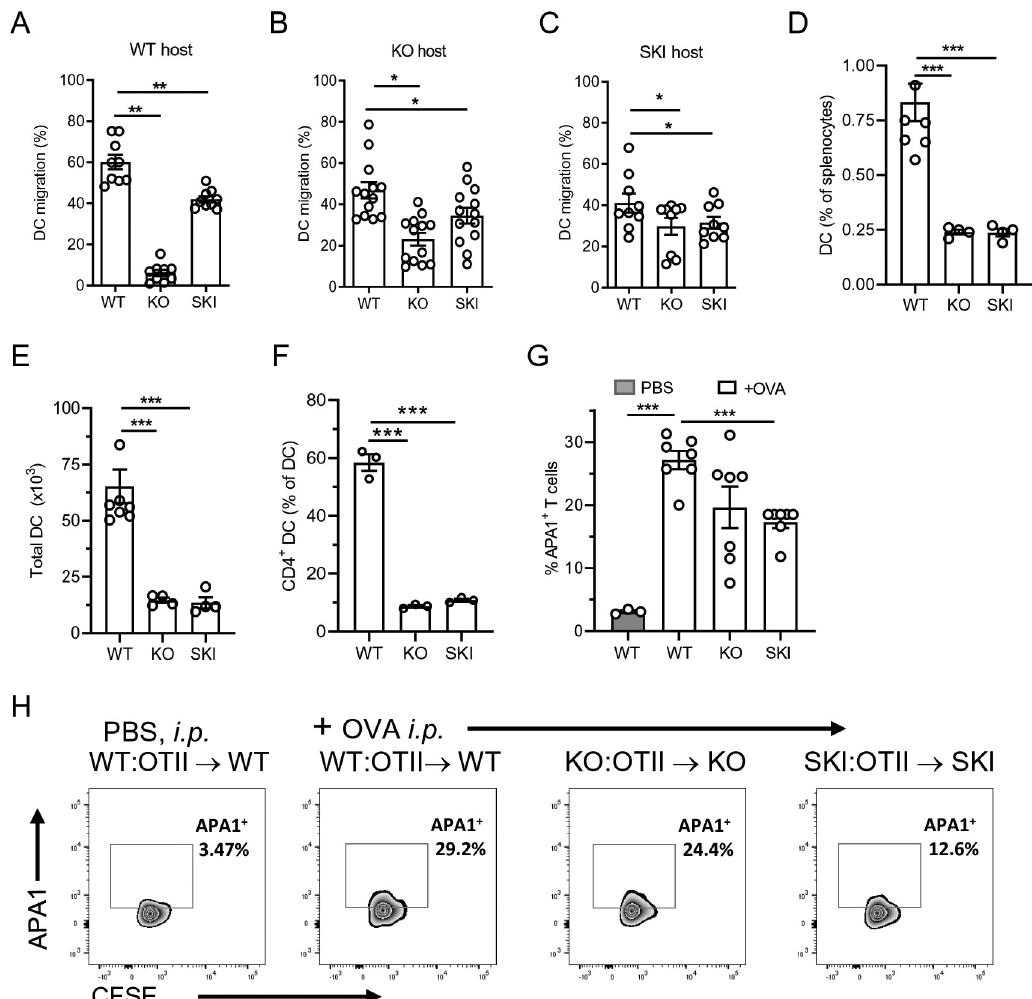
Fig 5. SIRP α - CD47 axis regulates phenotype and function of DCs. (A-C) Hock injected BMDC from Cd47 KO and SKI, compared to WT mice, exhibited reduced migration. Data are expressed as the % recovery of labeled live DC (% of total recovered). Data are means ± SEM from 3 independent studies with 3–4 mice per group per study. �� p < 0.01 by one-way ANOVA. (D, E) % DC and total DC number in spleens were reduced in Cd47 KO and SKI compared to WT mice. (F) CD4 + DCs as % of total spleen DCs. (G) Expression of APA1/1 TCR activation epitope in CD4 + WT OTII cells recovered from spleen of WT, Cd47 KO and SKI mice. Means ± SEM from 2 independent studies from 3–4 mice per group. ��� p < 0.001 by one-way ANOVA with Tukey test. (H) Representative flow cytometry histograms of APA1 staining in WT, SKI and KO mice after OVA immunization.